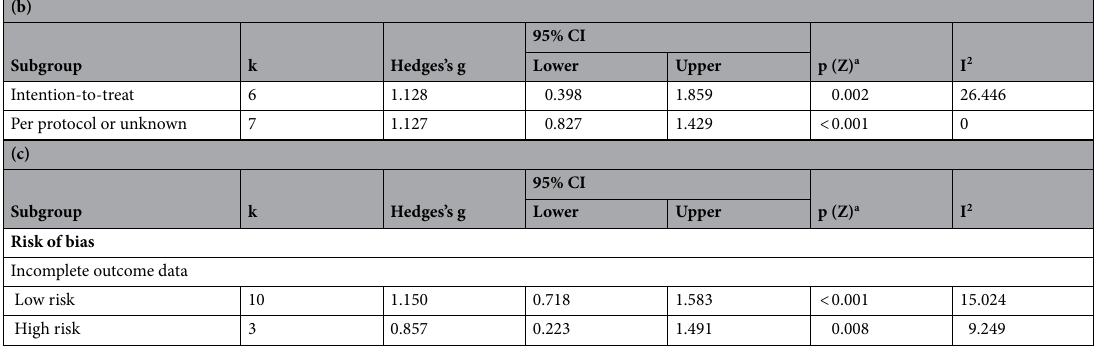
Table 6. Moderators of light treatment effect on phase shift by using subgroup analyses with mixed-effects models. a P value for the Z test of the moderator